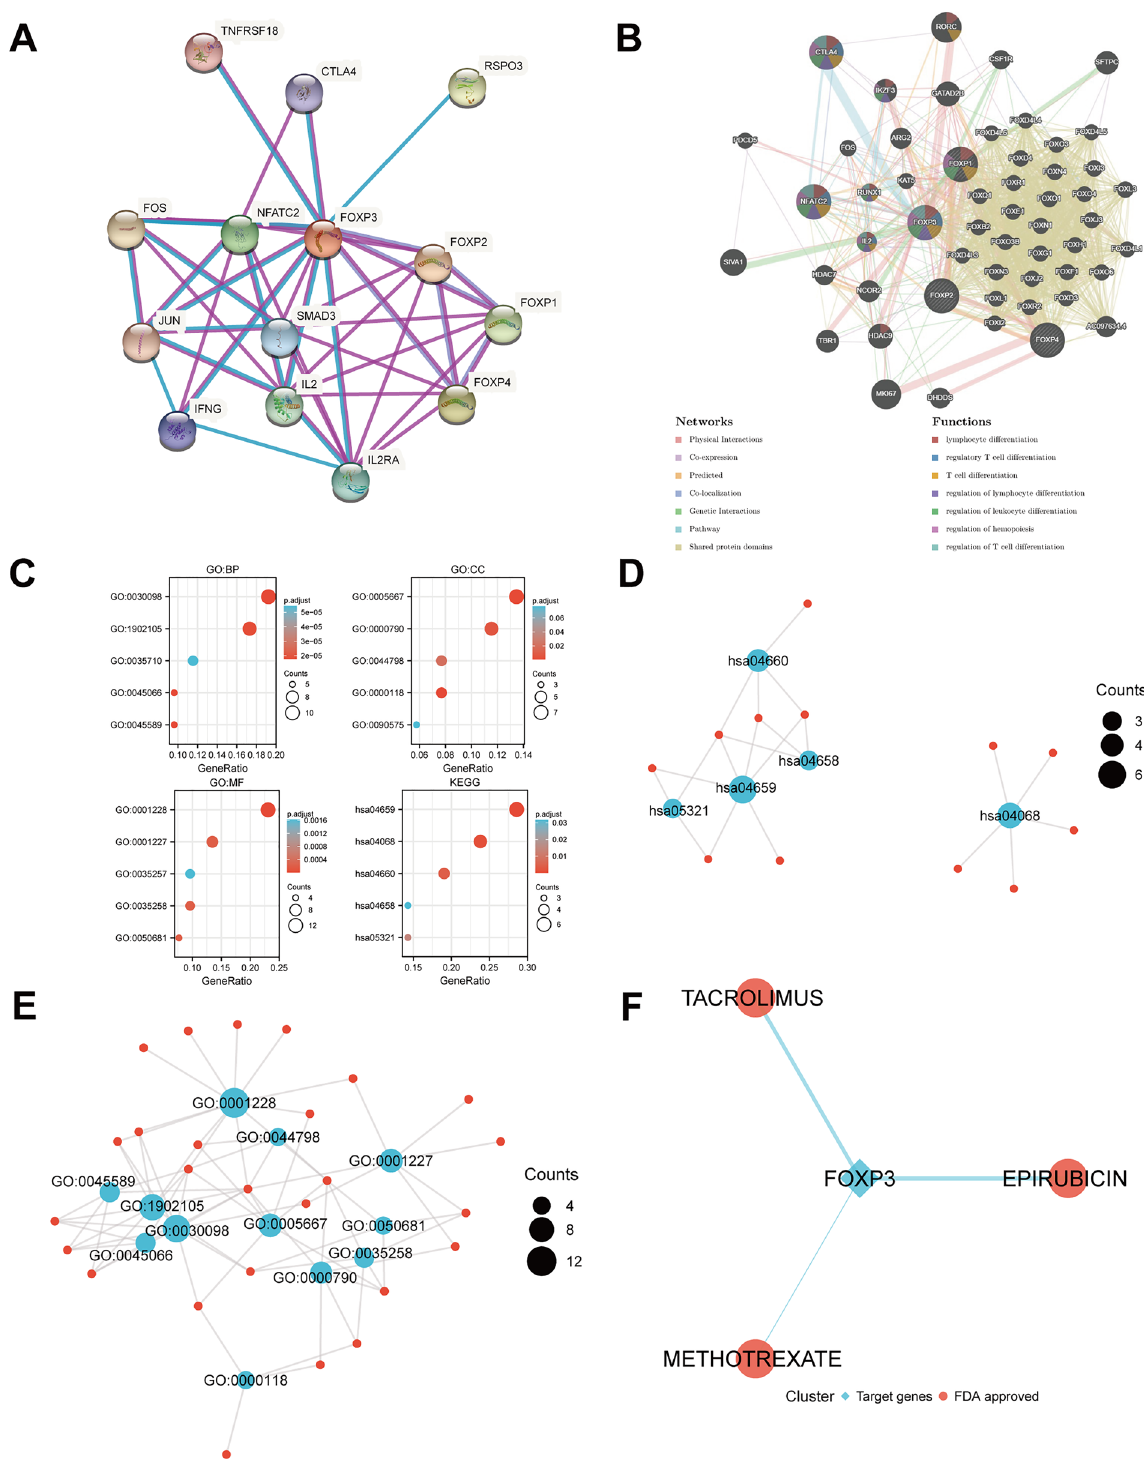
Figure 6. PPI network, neighbor gene network, interaction analyses of FOXPs, the functions of FOXPs, genes significantly associated with FOXPs alterations in BRCA and drug–gene interaction. ( A ) Protein–protein interaction network of different expressed FOXPs (STRING). ( B ) Gene–gene interaction network of different expressed FOXPs (GeneMANIA). ( C ) GO enrichment analysis predicted the functional roles of target host genes based on three aspects, including biological processes, cellular components, and molecular functions. The functions of FOXPs and genes significantly associated with FOXPs alterations were predicted by the analysis of KEGG. ( D , E ) Network of GO and KEGG enriched terms. ( F ) FOXP3 has significant correlations with drug- gene